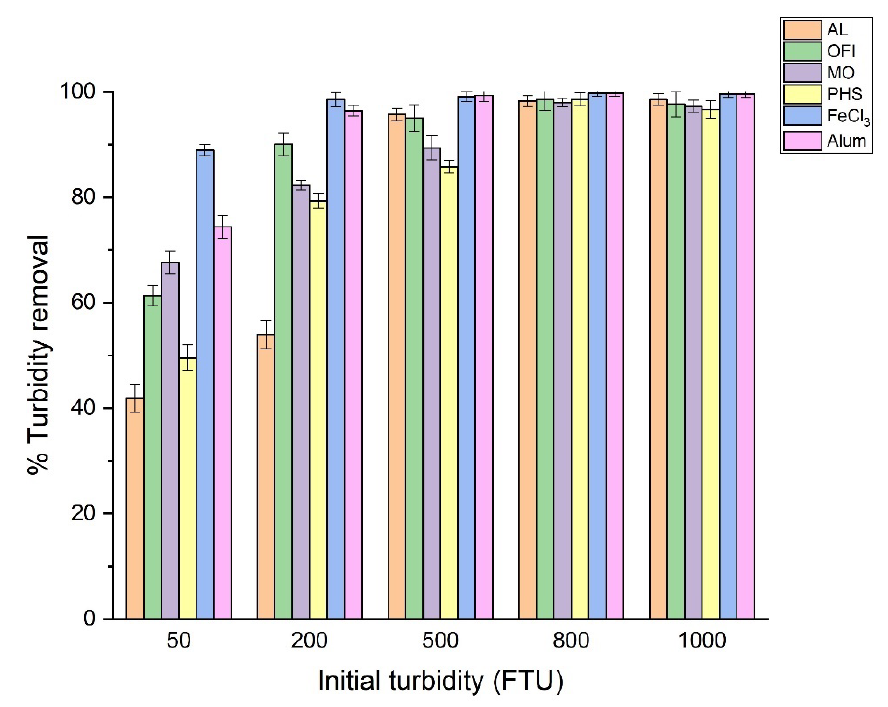
Figure 6. Effect of initial turbidity on the effectiveness of the coagulants. Table 2. Comparison of the studied bio-coagulants with prior research.